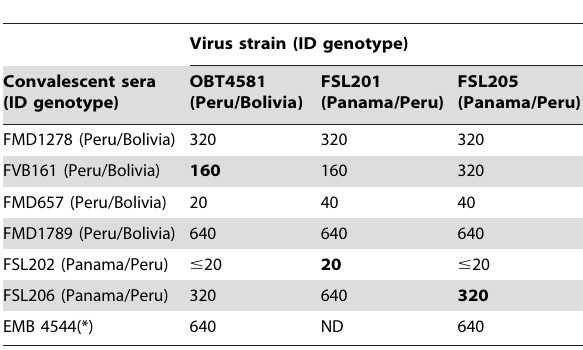
Table 2. Antigenic characterization of the isolates.